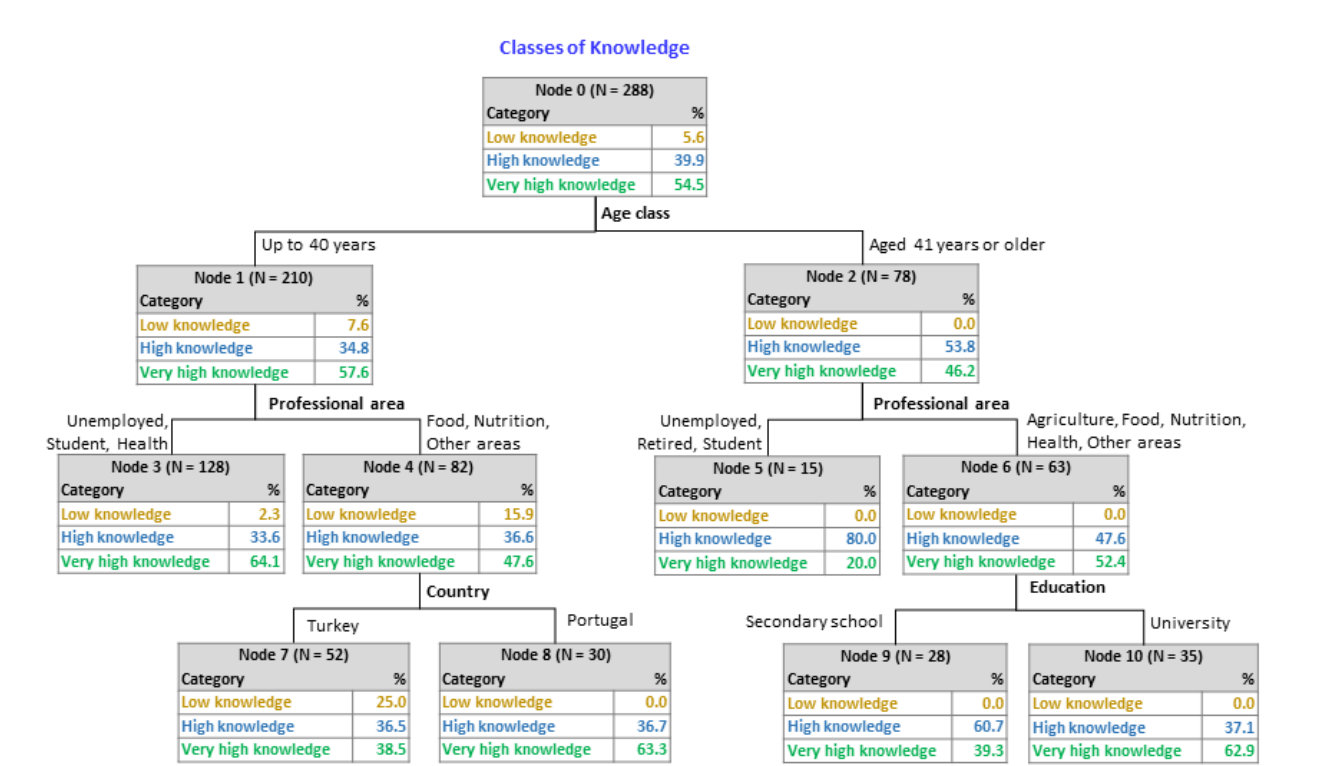
Figure 4. Tree classification for the influence of the sociodemographic variables on the level of knowledge.